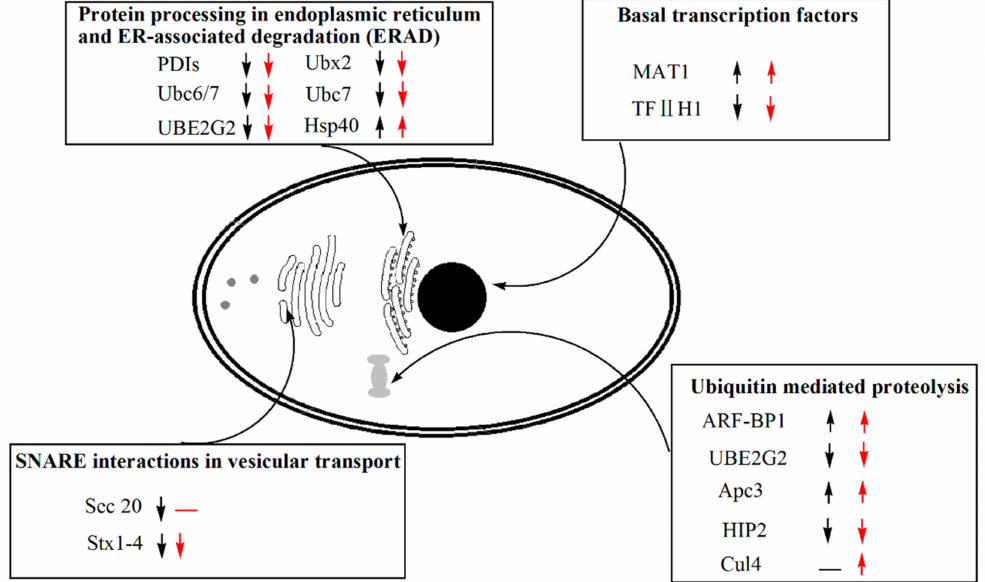
Figure 5. Overview of DEGs in peroxisome in PI1 and PI2 in comparison to BI. Up-regulated or down-regulated genes in comparison to BI ( p adj < 0.01) are depicted with up or down arrow (black arrow stands for sample PI1, red arrow indicates PI2), respectively. A dash line indicates no significant change in comparison to